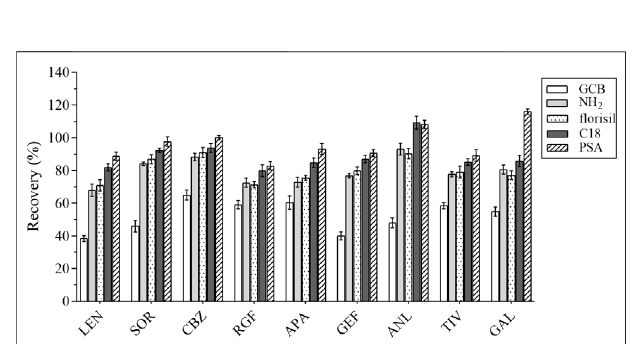
FIGURE 4 | The recovery results of all analytes with different masses of anhydrous magnesium sulfate.